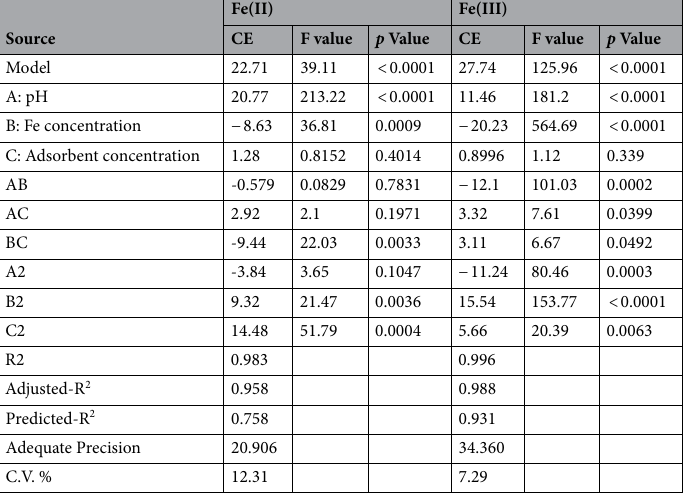
Table 2. Analysis of variance (ANOVA) for response surface quadratic model of cellulose nanocrystals/ graphene oxide film. CE: coefficient of estimate. C.V. %: percentage coefficient of variation.